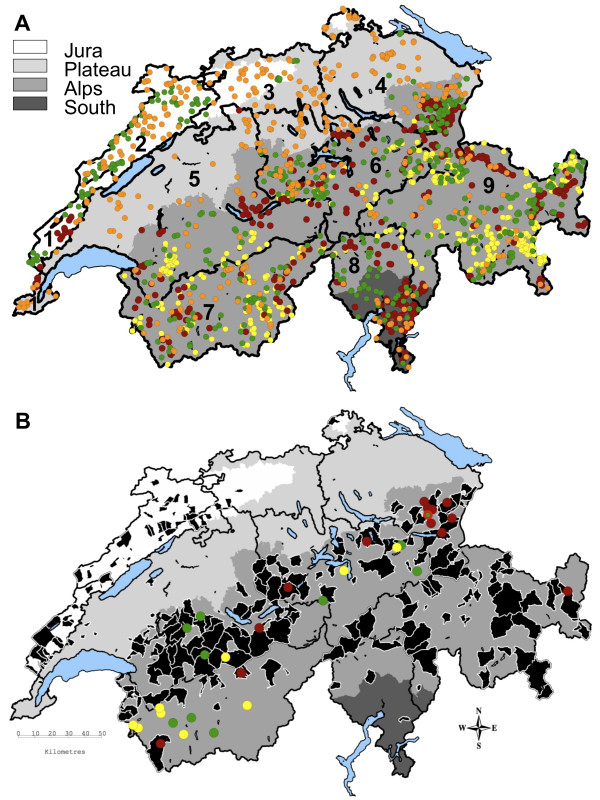
Map of Switzerland showing (A) sampling units and sampled animals and (B) seropositive animals. Grey shaded areas represent different bioregions, major lakes are in blue. Numbers refer to sampling units: 1) Jura-South, 2) Jura-North, 3) North-West, 4) North-East, 5) Centre-West, 6) Centre-East, 7) South-West, 8) South-Centre, 9) South-East. Colored dots correspond to animals of different species: Orange: roe deer; Red: red deer; Green: chamois; Yellow: ibex. The seropositive chamois (green dot in Figure
1B) located in the unit North-East and indicated by a bright red halo was also positive by PCR. Black areas in Figure
1B refer to communities in which at least one domestic animal was found positive for bovine viral diarrhea virus (persistently infected cattle detected during the summer pasturing season in the frame of the eradication program; data obtained from the Swiss Federal Veterinary Office).